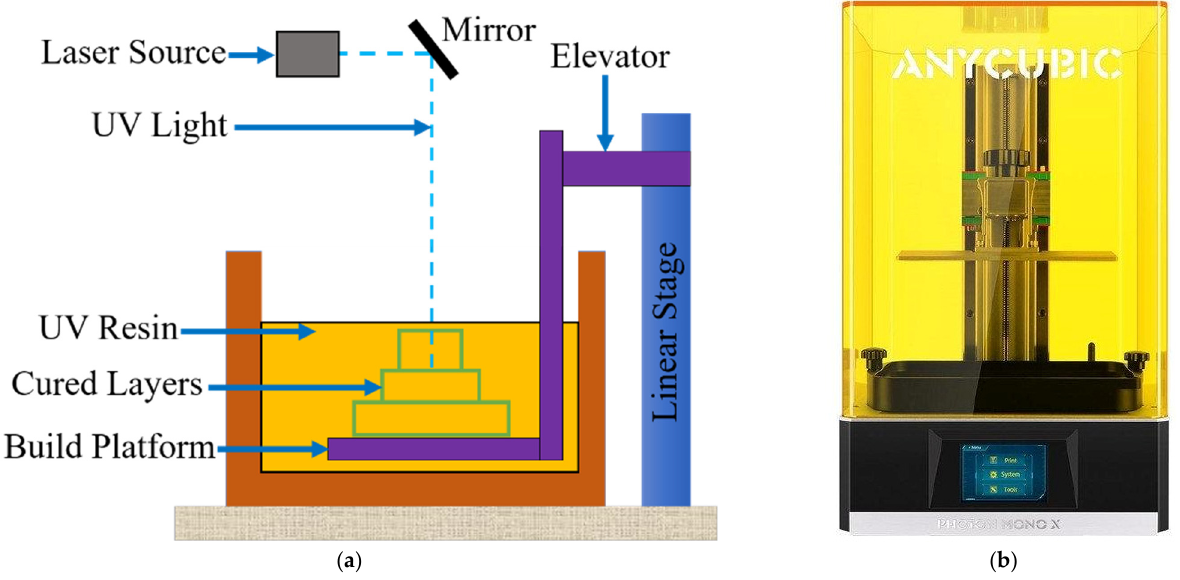
Figure 3. Schematic of SLA system ( a ) SLA-based 3D printing process ( b ) SLA-based 3D printer.